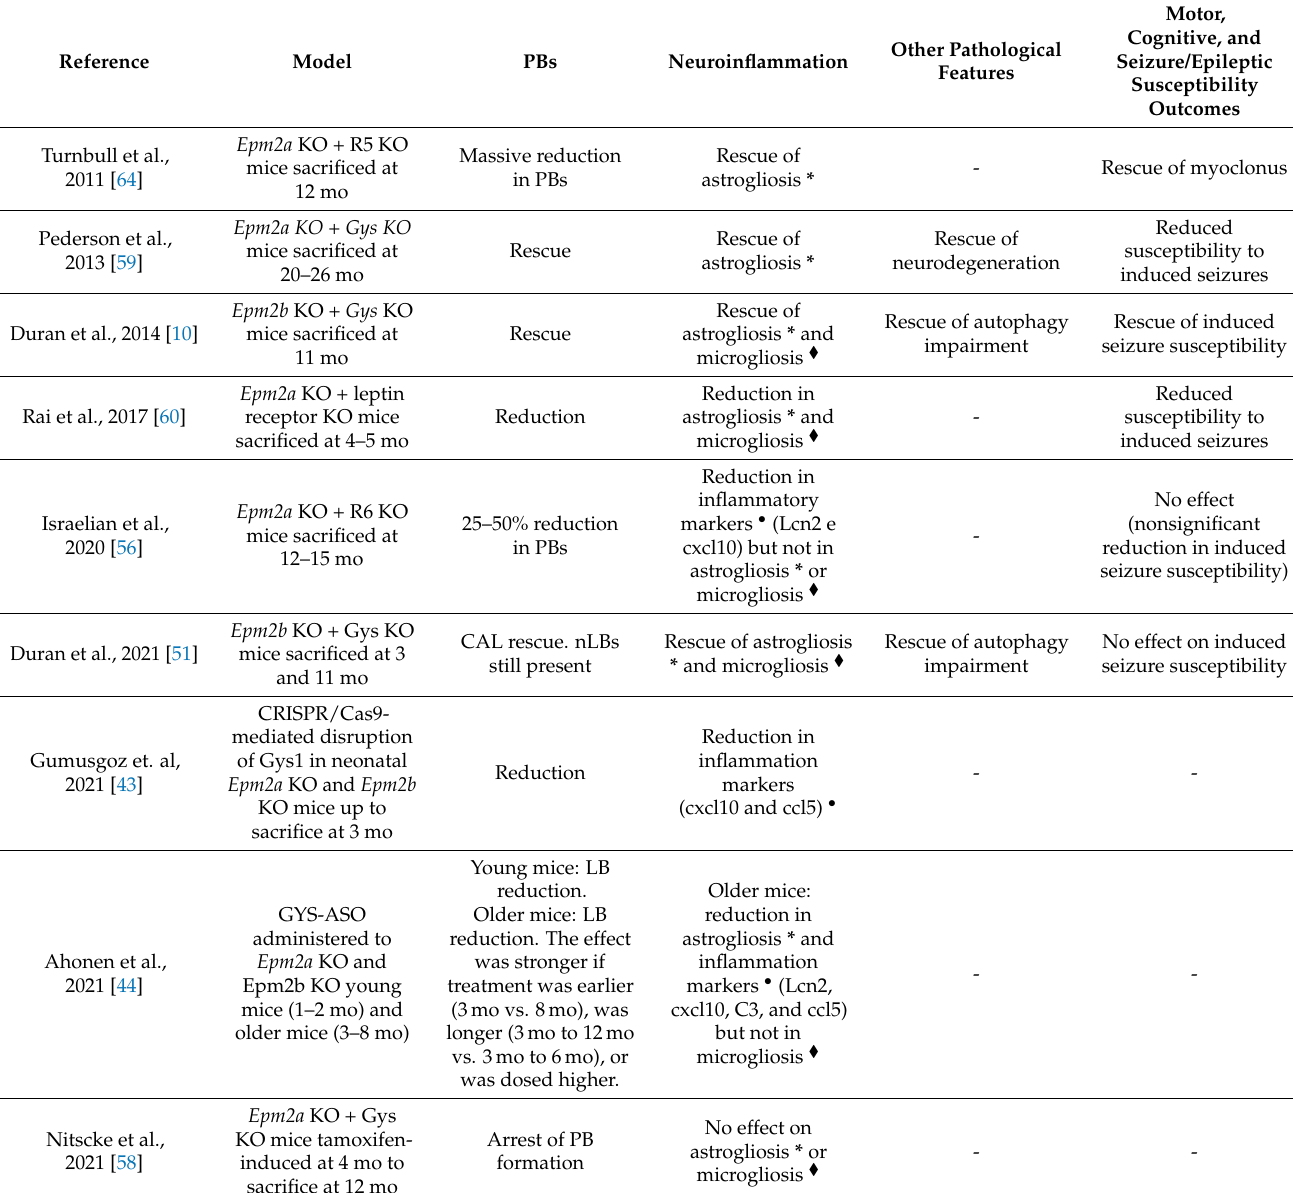
Table 2. Summary of studies describing the effects of the inhibition of glycogen synthesis in animal models of